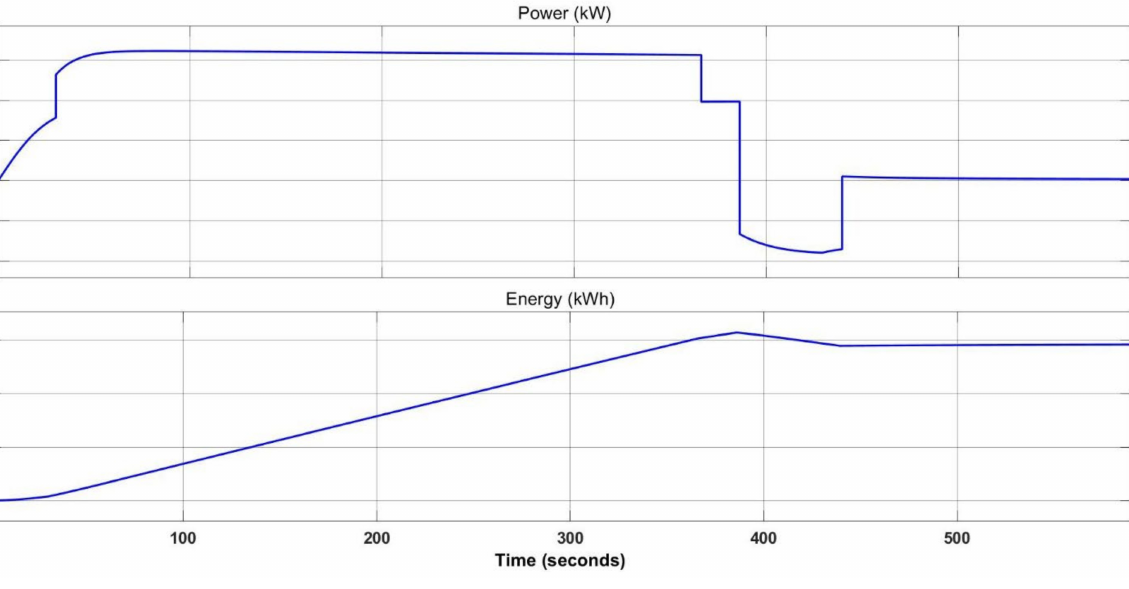
Figure 13. Power demand and energy consumption of electric WT-9 Dynamic—tow at height 600